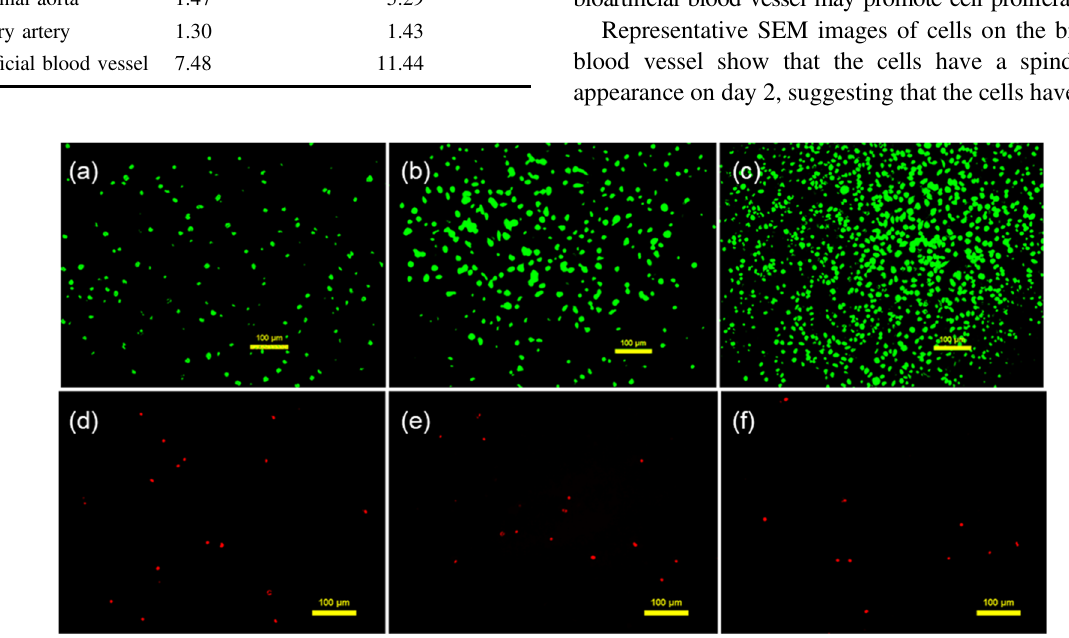
represents the petri dish group and KBZ represents the blank control group. c Stacked histogram of OD values. d Cell viability of